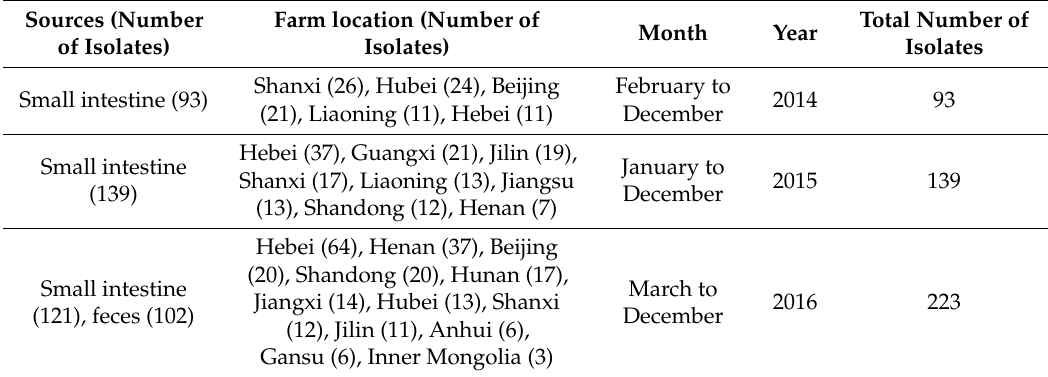
Table 1. Month, year, and farm location of sample collections from piglets with